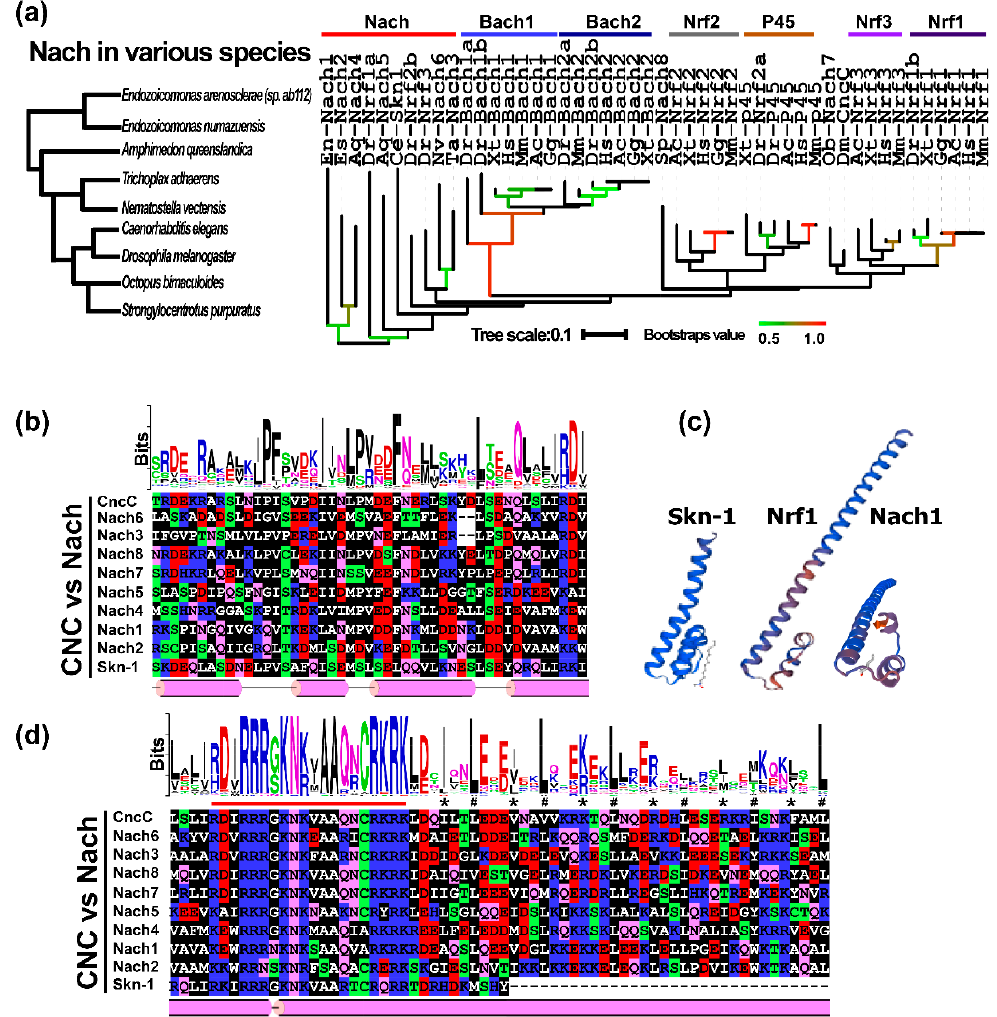
Figure 2. Phylogenetic analysis and sequence structure of the CNC-bZIP proteins in various taxas. ( a ) Left panel shows the putative evolution of distinct organisms with a novel subgroup Nach, which is located in the right smaller neighbor-joining (NJ) phylogenetic tree that was generated by using the MEGA 6.0-based analysis of the full-length Nach/CNC-bZIP proteins across 15 different species with 1000 bootstrap replicates. Multiple sequence alignments of both CNC ( b ) and BRLZ ( d ) domains with distinct characteristics were analyzed by using different tools DNAMAN8.0, PSIPRED, MEME and Web-logo (obtained from all Nach/CNC-bZIP proteins) with distinct default parameters. The red line represents the nuclear localization signal (NLS) in the basic region, while the symbols * and # represent the “ a ” and “ d ” positions in heptad repeats of LZ region, respectively. Similar secondary ( b , d on the bottoms) and tertiary ( c ) structures of the CNC-BRLZ domains within Nrf1 and Nach1 were modeled by using the SWISS-MODEL tool, based on the temple of known homological domain structure of Skn-1.